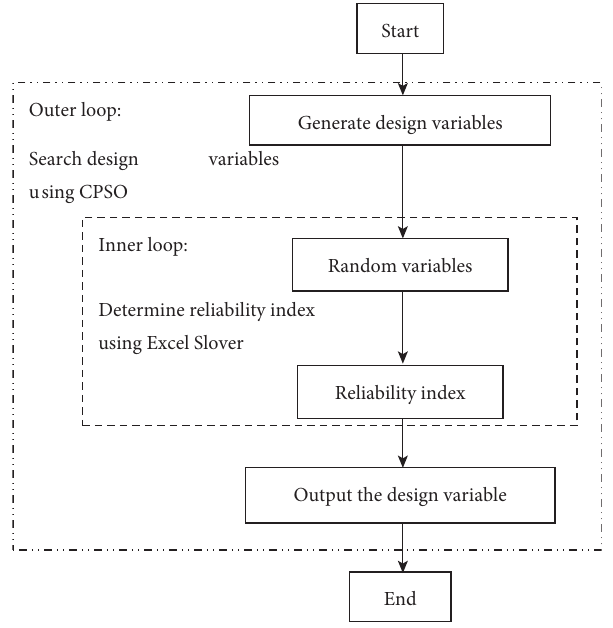
Figure 5: Flowchart of the RBD using Table 1: Statistical parameters of the random variables in example 1.